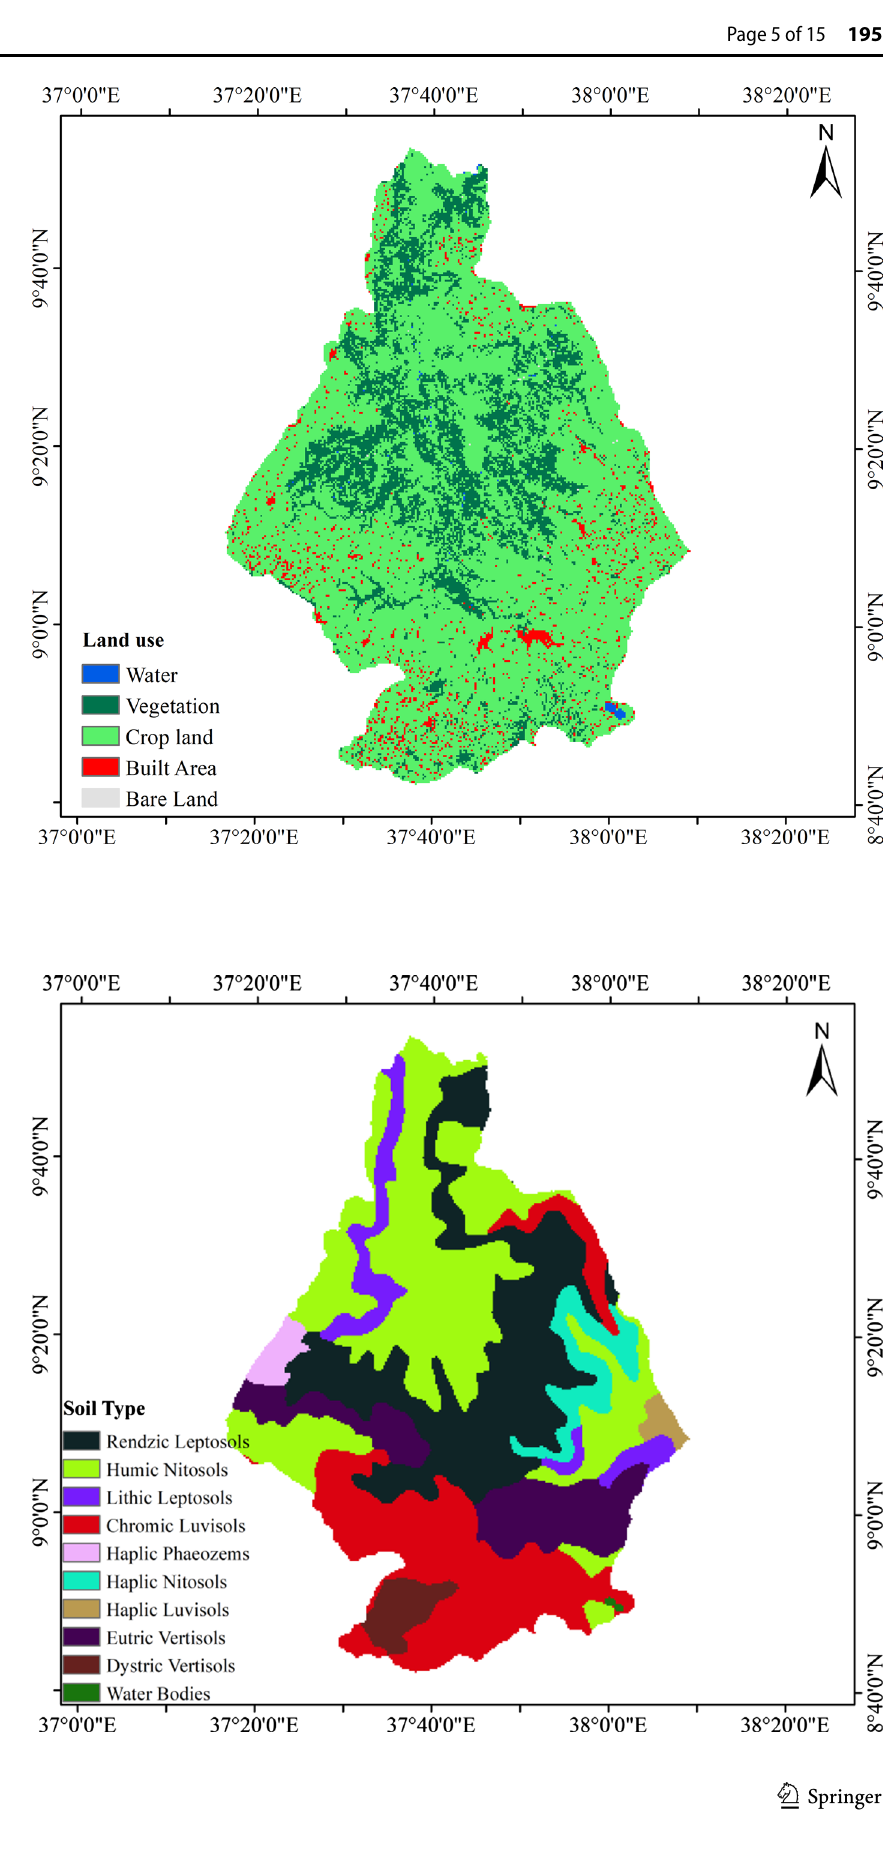
Fig. 3 Land use of the Guder Watershed